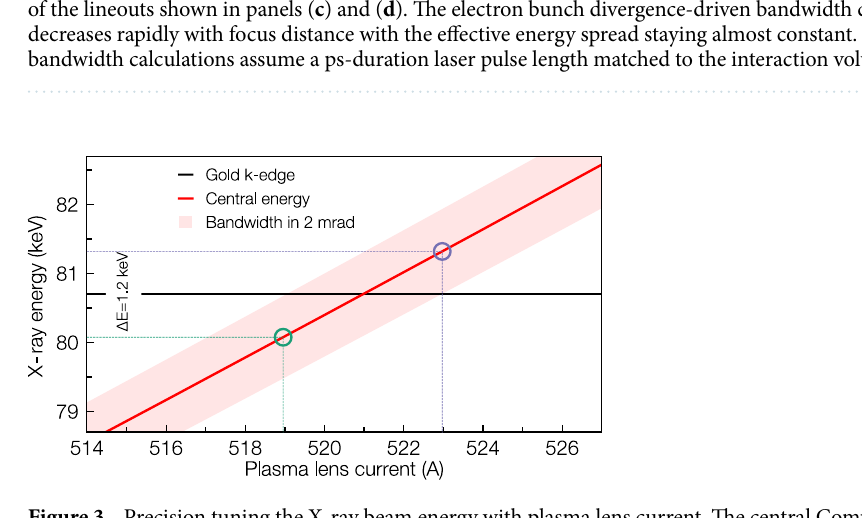
Figure 3. Precision tuning the X-ray beam energy with plasma lens current. The central Compton scattered X-ray energy (red line) and the FWHM divergence emitted into a 2 mrad cone full-angle are shown. A narrow bandwidth allows a 1.2 ke V energy separation around the gold k-edge (black